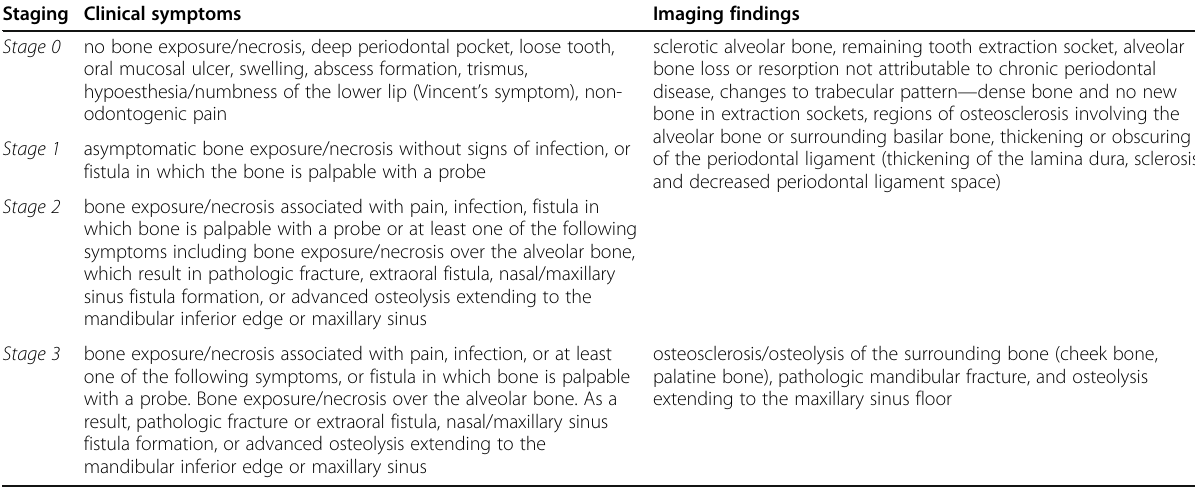
Table 1 Clinical and imaging findings of MRONJ in each stage Staging Clinical